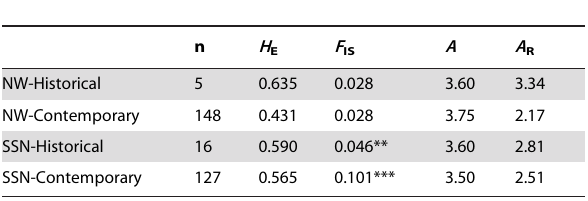
Table 1. Estimates of genetic diversity for the northwest (NW) and southern Sierra Nevada (SSN) at 10 microsatellite loci: sample size (n), expected heterozygosity ( H E ), proportional excess of homozygotes ( F IS ), mean number of alleles ( A ), and allelic richness ( A R ).